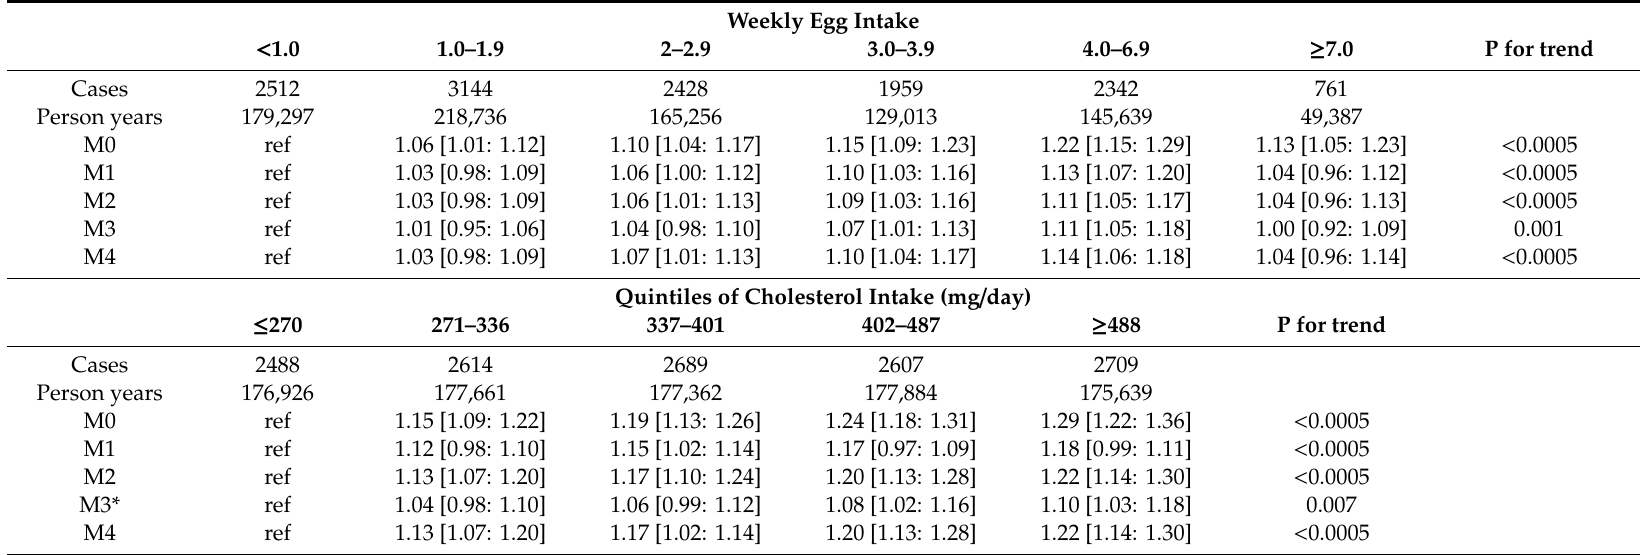
Table 2. BMI adjusted and multivariate adjusted cox proportional hazard models for incident hypertension risk based on time varying distributions of egg consumption and cholesterol consumption, with follow-up from